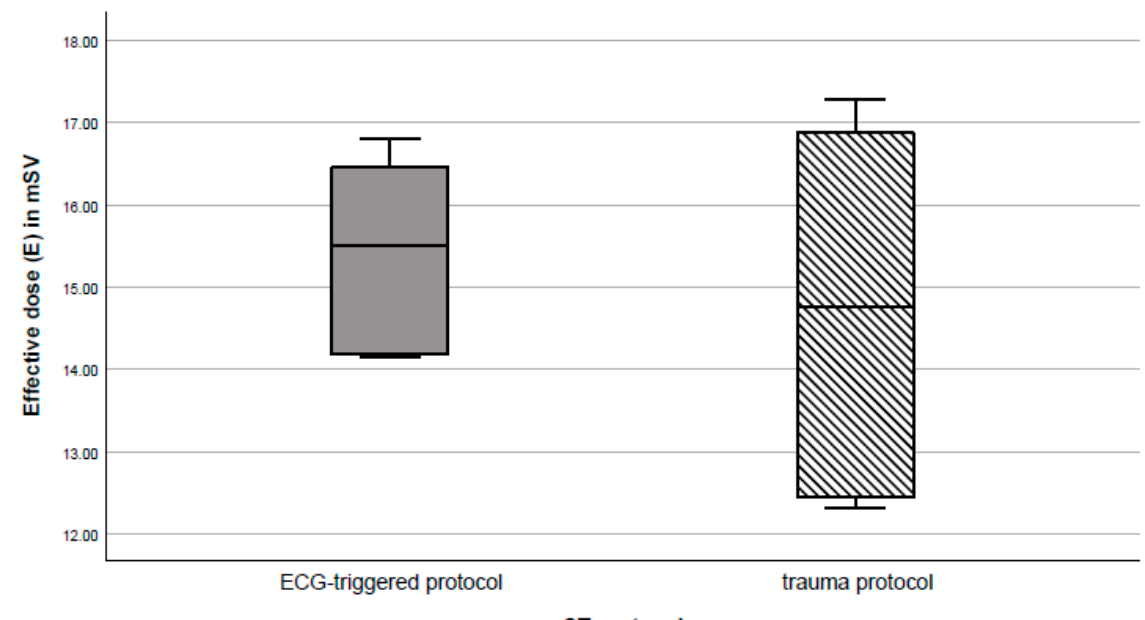
Figure 3. Comparison of medians and interquartile ranges of radiation dose (effective dose) with the two computed tomography protocols investigated. The difference is not statistically significant ( p = 0.946).